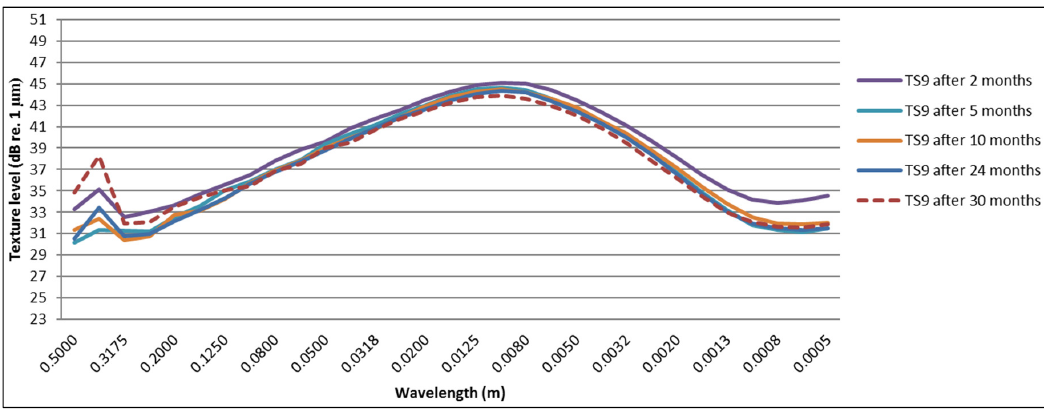
Figure 20. Change in texture spectra over a period of 30 months for Test Section 9 (30 ‐ mm thickness).